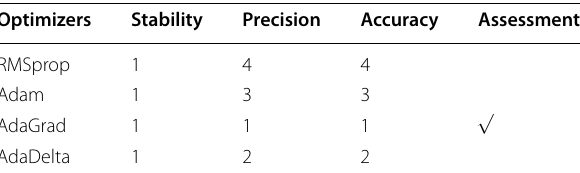
Table 2 Assessment of different optimizers using